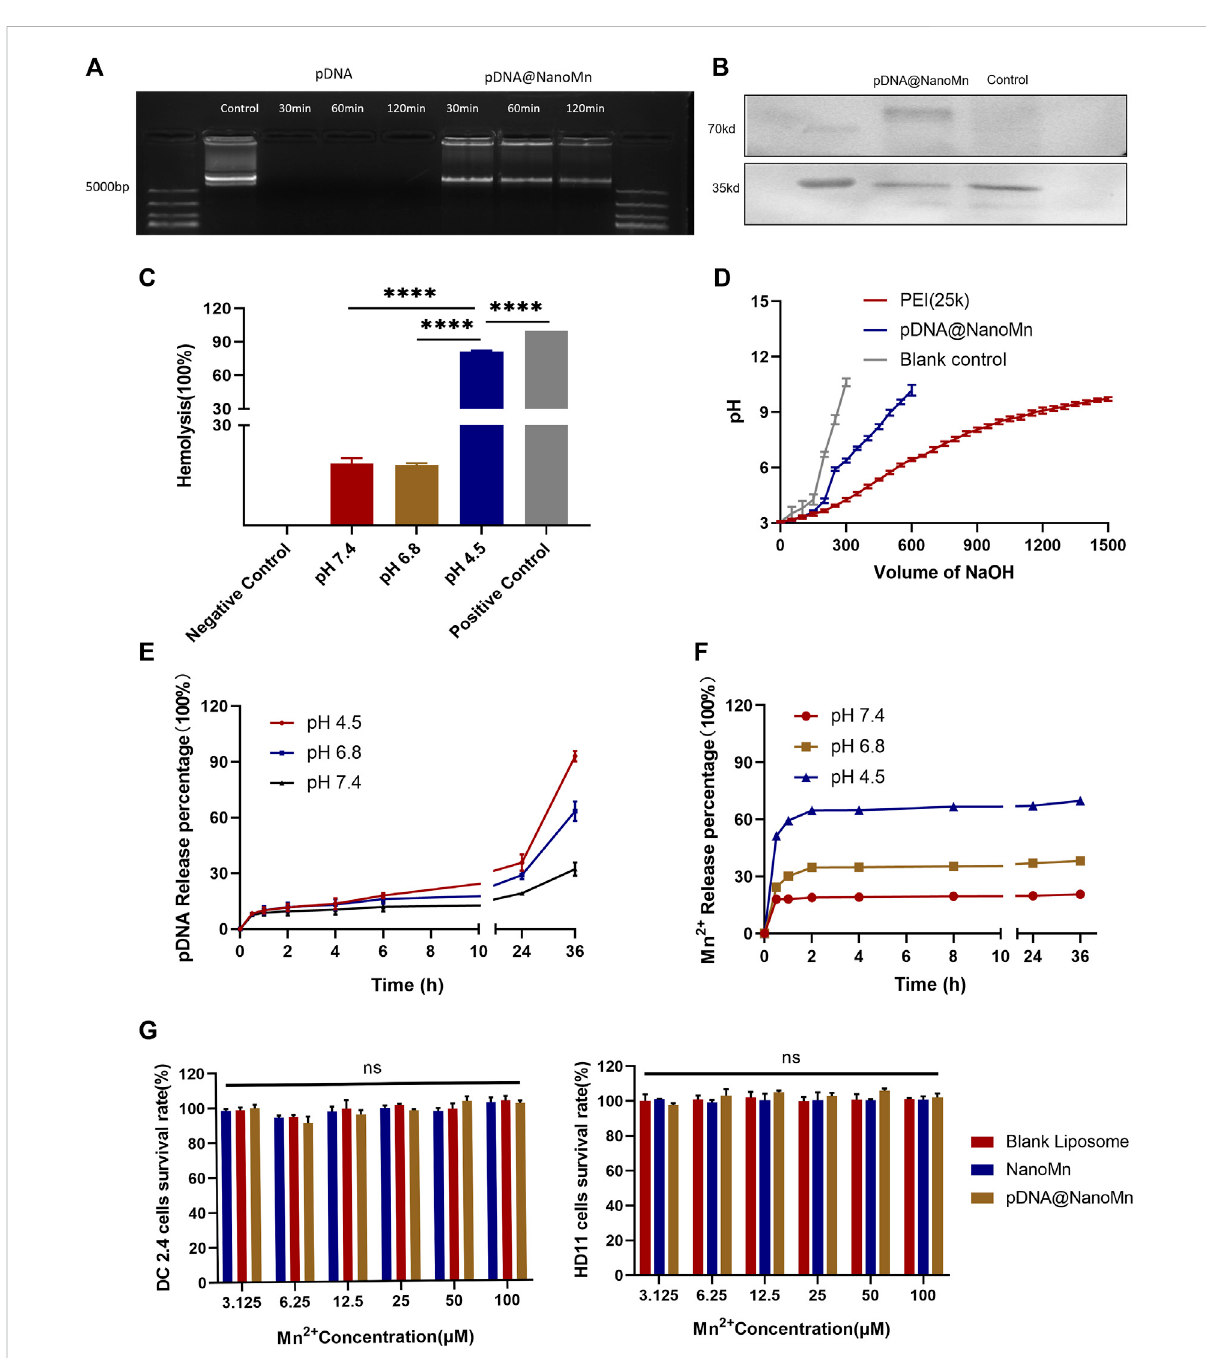
FIGURE 2 (A) The protective effect of pDNA HA Re11@NanoMn on pDNA HA Re11. (B) Western blot validation of pDNA HA Re11@NanoMn expression in DC 2.4. (C) The lysis of erythrocytes bypDNA HA Re11@NanoMn after incubation with erythrocytes for 1 h underphysiological conditions. (D) Buffer capacitydeterminationofpDNAHARe11@NanoMn. (E) pDNAHARe11@NanoMnreleasepro fi leofpDNAHARe11inPBSbufferatdifferentpHvalues (4.0,6.8, and7.4). (F) Mn 2+ release pro fi lesofpDNAHARe11@NanoMninPBS bufferatdifferentpHvalues(4.0,6.8,and7.4). (G) CCK-8 kitsverify the safety of pDNA HA Re11@NanoMn and NanoMn on DC2.4 and HD11